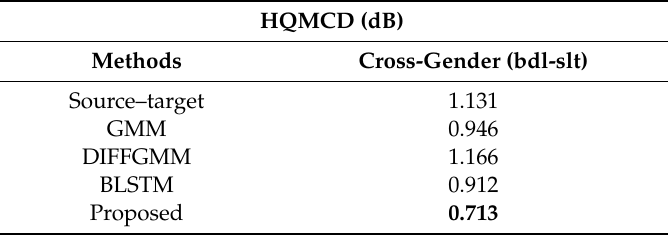
Table 3. Mean high-quefrency sub-band Mel-cepstrum distortion (HQMCD) for different methods on CMU ARCTIC (15 dB babble add to source).